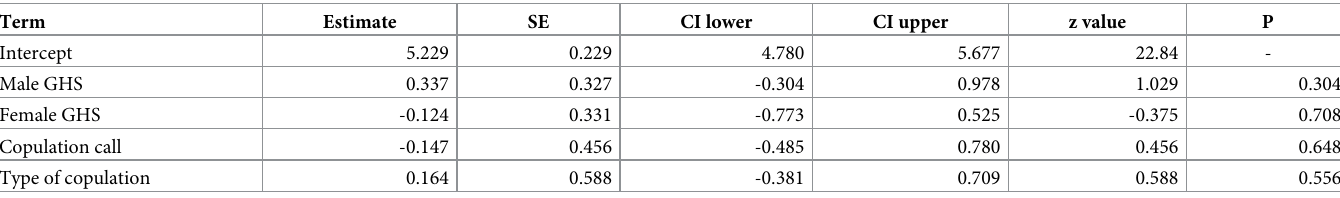
Table 6. PCG duration model by females. GLMMs evaluating if the duration of female PCG was affected by the presence of copulation calls and type of copulation (ejac- ulatory vs non-ejaculatory).